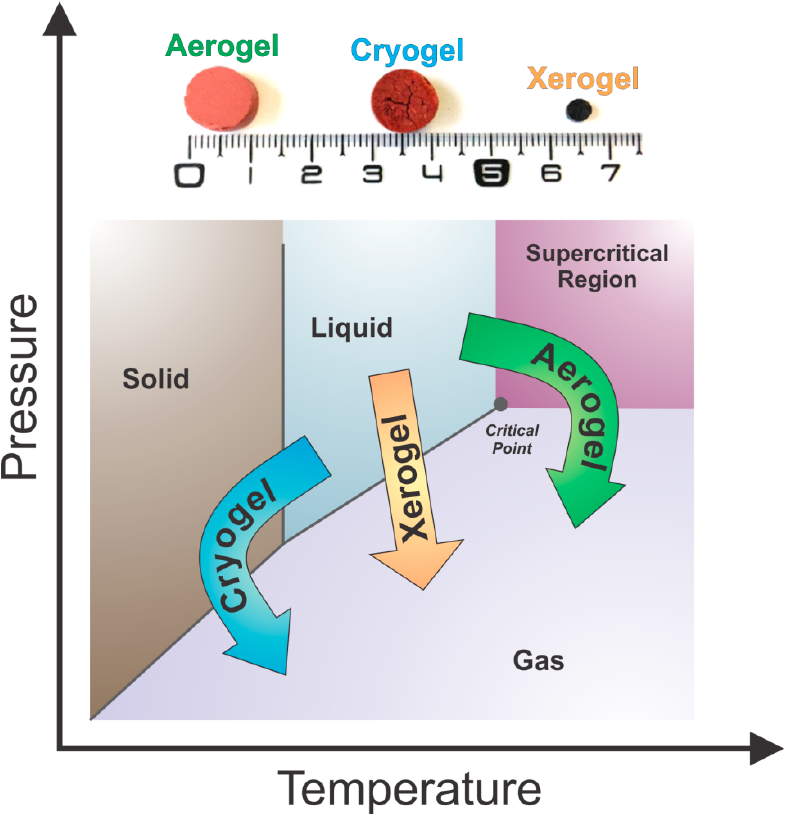
Figure 10. Phase diagram of the solvent within the gel structure and the representation of the different drying methods with their respective porous materials, adapted with permission from reference [92].